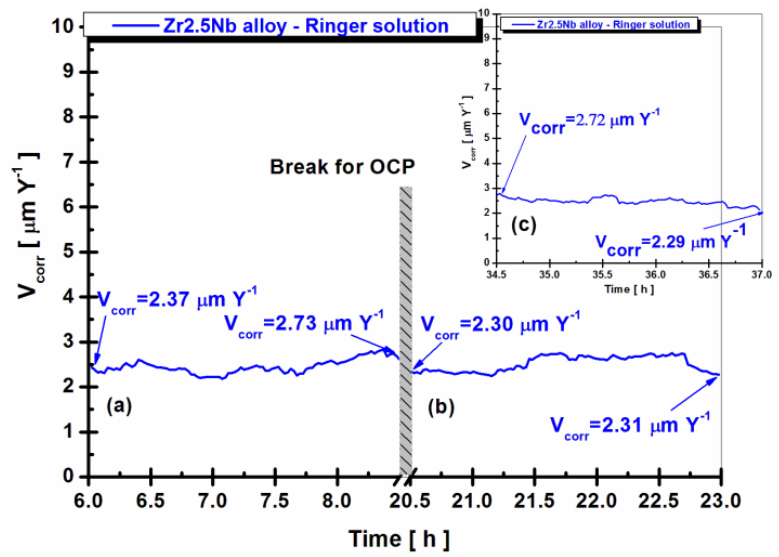
Figure 5. Corrosion rate (V corr ) for Zr2.5Nb alloy immersed in Ringer’s solution: ( a ) primary segment (V corr1 ), ( b ) secondary segment (V corr2 ), and ( c ) tertiary segment (V corr3 ).